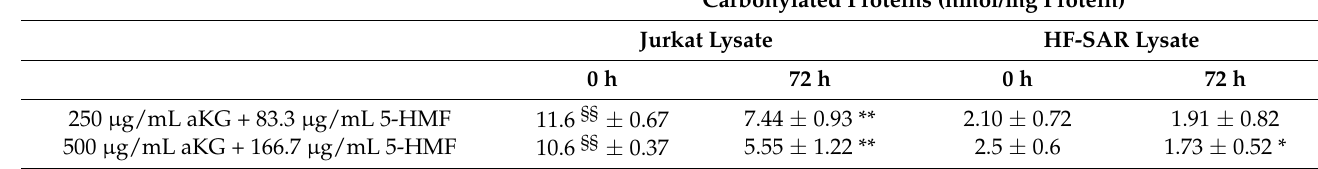
Table 3. Carbonylated proteins of Jurkat and HF-SAR lysates after 0 and 72 h incubation in absence or presence of 500 µ g/mL aKG + 125 µ g/mL 5-HMF and 500 µ g/mL aKG + 62.5 µ g/mL 5-HMF ( n = 5). * p < 0.05: significance between 0 h and 72 h incubated aKG + 5-HMF solutions. ** p < 0.01: significance between 0 h and 72 h incubated aKG + 5-HMF solutions. §§ p < 0.01 = significance between Jurkat cell and HF-SAR lysate. Carbonylated Proteins (nmol/mg